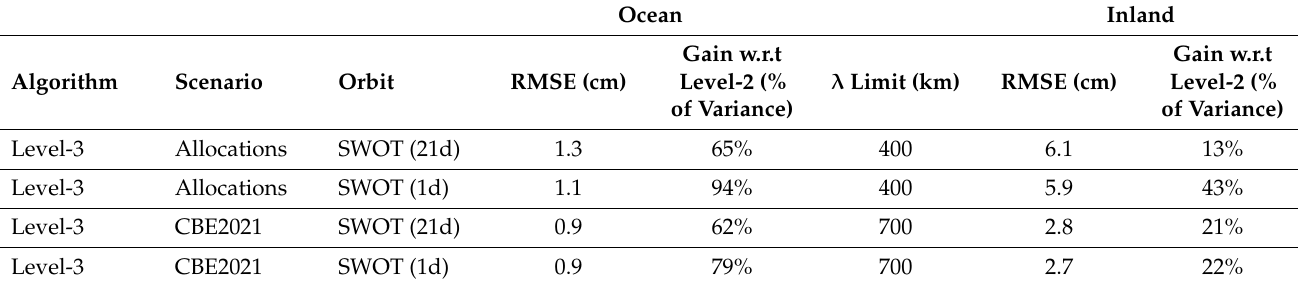
Table 3. Overview of the global Level-3 performance after data-driven calibration for different scenarios. The left columns are for the global ocean (sea-ice regions are excluded) with the Root Mean Square Error (RMSE) in cm, the gain with respect to the Level-2 RMSE of Table 2 (in % of variance) and the wavelength λ where the calibration stops to be beneficial (measured from the power spectra of Figure 17). The right columns are for the inland regions with the RMSE in cm and the gain with respect to the Level-2 performance of Table 2 (expressed in % of variance). Ocean